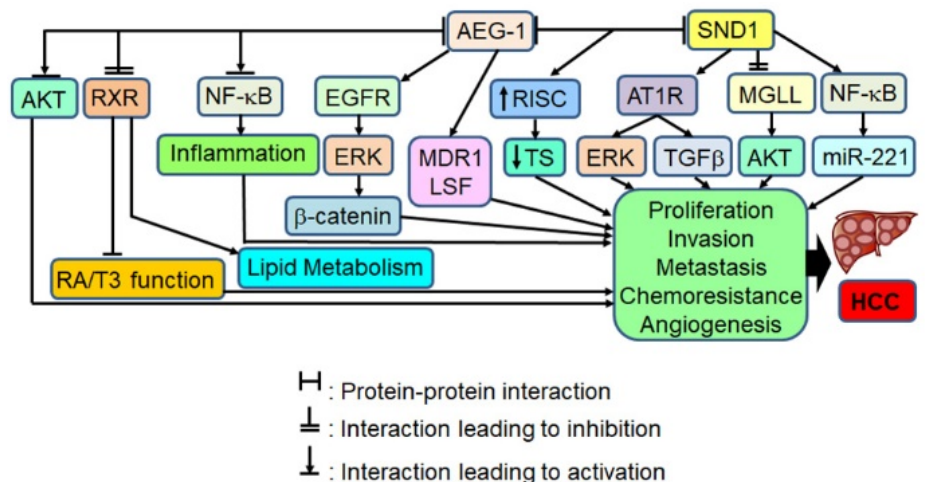
Figure 2. Important molecular interactions mediating AEG-1 function. AEG-1 interacts with a variety of proteins to activate oncogenic signaling pathways and modulate cellular metabolism to promote hallmarks of cancer and hence tumorigenesis. Interaction of AEG-1 with the oncogene SND1 increases RISC activity resulting in decrease in tumor suppressor genes, and activates ERK, AKT and NF- κ B pathways. AEG-1 directly interacts with multiple components of NF- κ B signaling pathways promoting inflammation. AEG-1 interacts with and inhibits RXR function which results in modulation of lipid metabolism and functions of vitamins and hormones. AEG-1 directly interacts with AKT to increase the duration of AKT activation. AEG-1 binds to MDR1 mRNA and increases its translation and increases the level of the transcription factor LSF contributing to chemoresistance. RXR: Retinoid X receptor, RA: Retinoic Acid, T3: thyroid hormone, EGFR: Epidermal growth factor receptor,